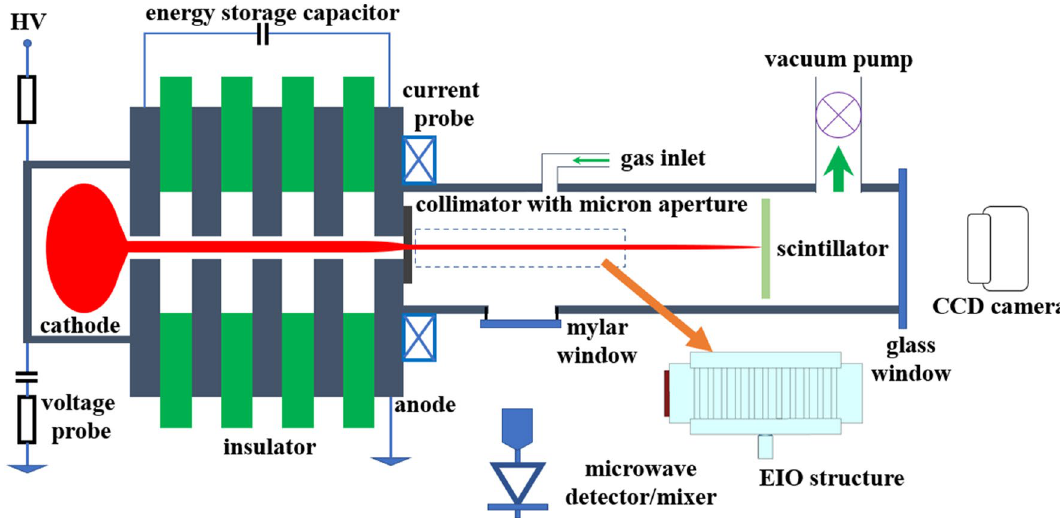
Figure 3. The schematic of the PS discharge experimental